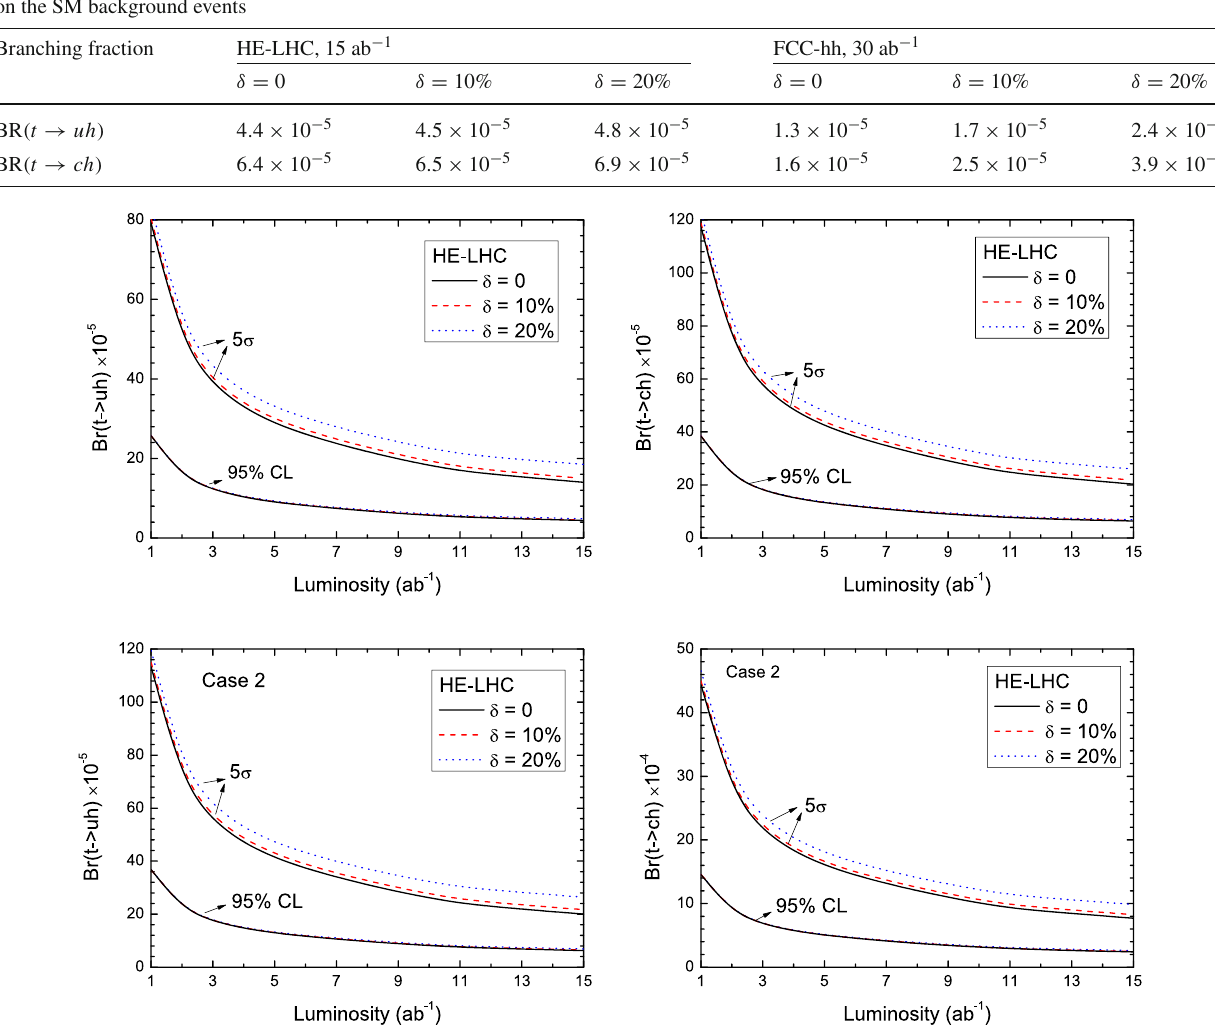
Table 4 The upper limits on BR ( t → qh ) at 95% CL obtained at the HE-LHC and FCC-hh. We consider systematic errors of 0%, 10% and 20%